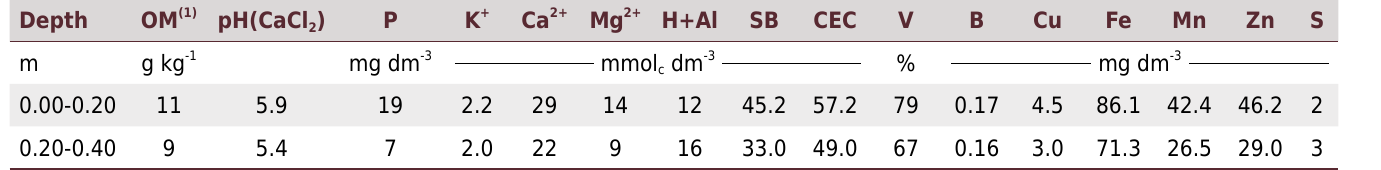
Table 1. Soil chemical properties in depths of 0.00-0.20 and 0.20-0.40 m, prior to experiment Depth